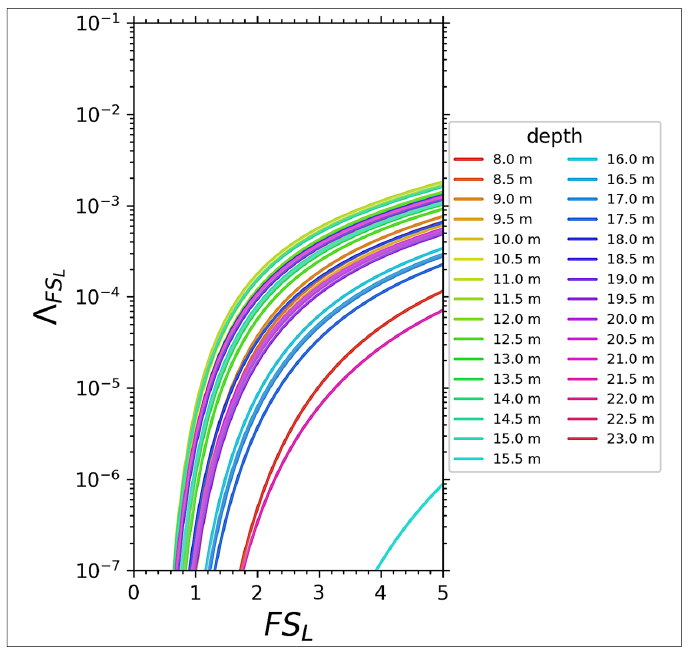
Figure 4. Mean annual rate of non-exceedance for FS L for the NPP Paks site, calculated applying the method of Kramer and Mayfield [16] combined with the Boulanger and Idriss CPT-based method [13].